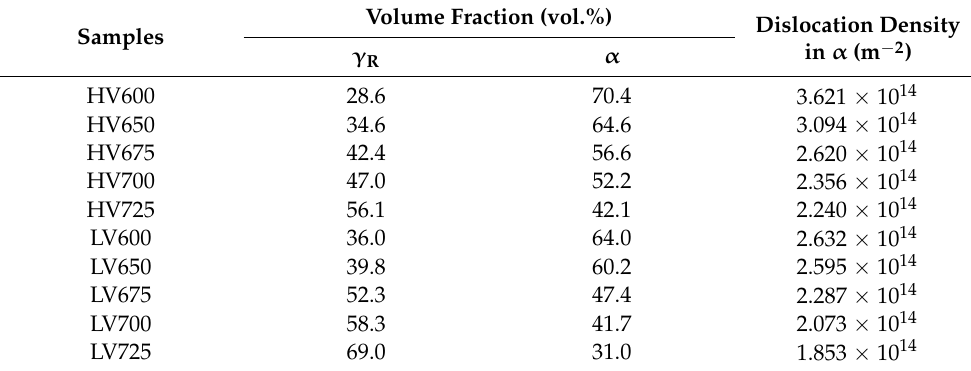
Table 2. The volume fraction of retained austenite and dislocation density of ferrite calculated from the XRD patterns ( γ R : retained austenite; α : ferrite).